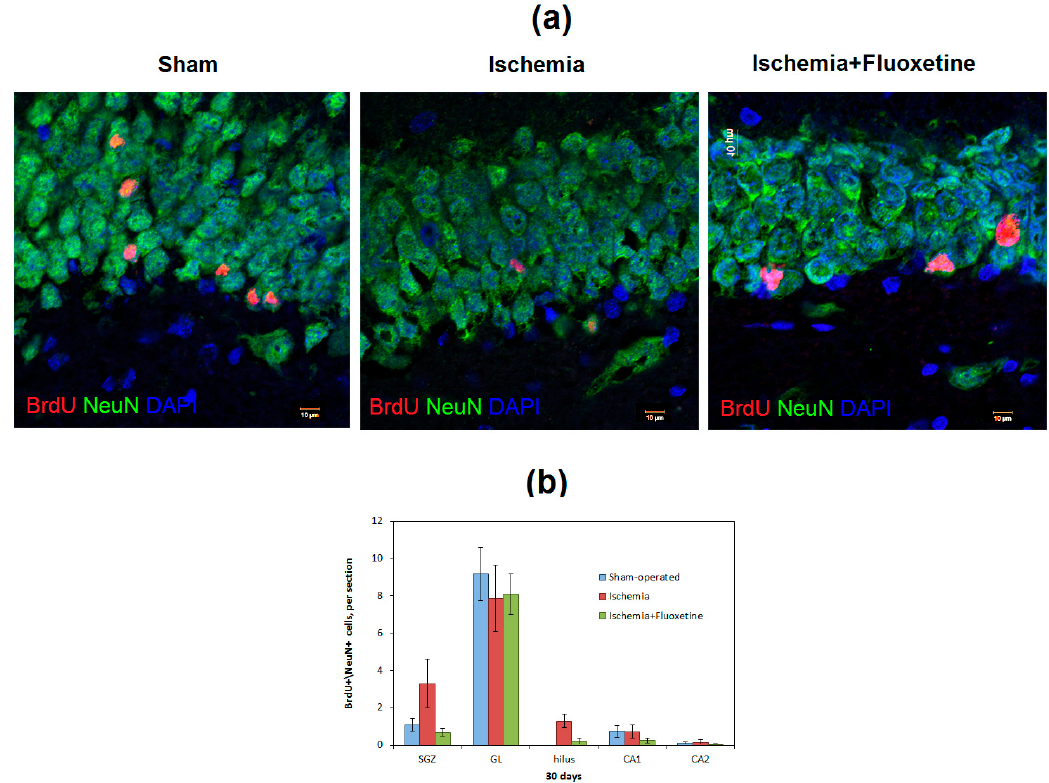
Figure 5. Fluoxetine effect on maturation of newborn neurons. ( a ) Micrographs of the DG of the hippocampus in the sham-operated animals, positive controls, and fluoxetine-treated animals at day 31 after GCI. Brain sections were stained with BrdU, NeuN and DAPI, 63× magnification; ( b ) Comparison of the number of NeuN+\BrdU+ cells in the regions of the hippocampus between the groups. No significant differences between the groups.